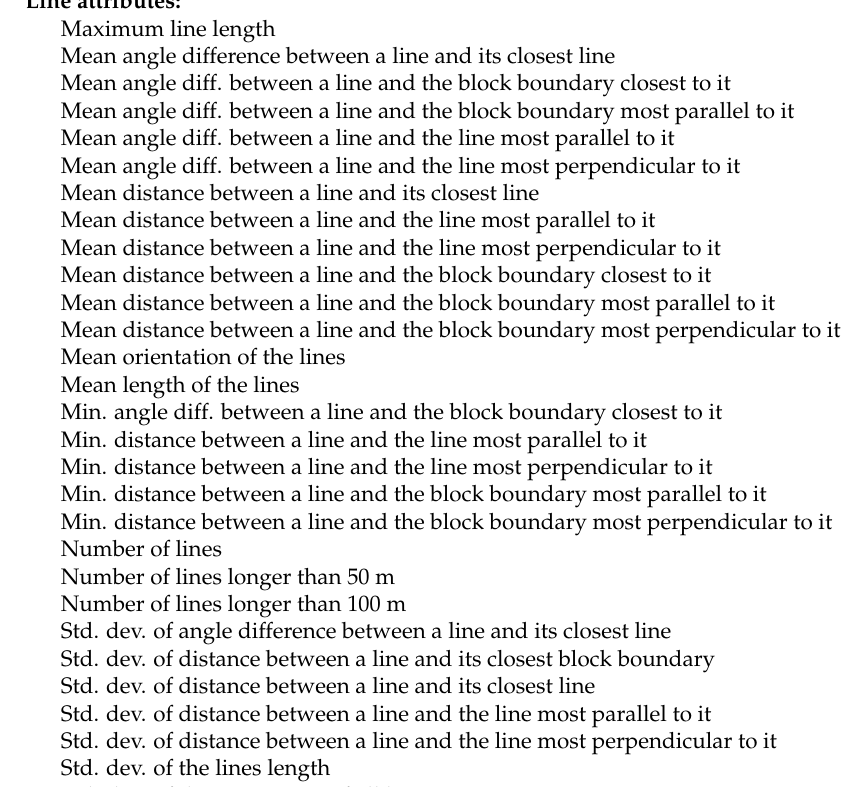
Table 2. Attributes computed from the lines extracted from the Synthetic Aperture Radar intensity images of each block. The line extraction procedure is described in detail in